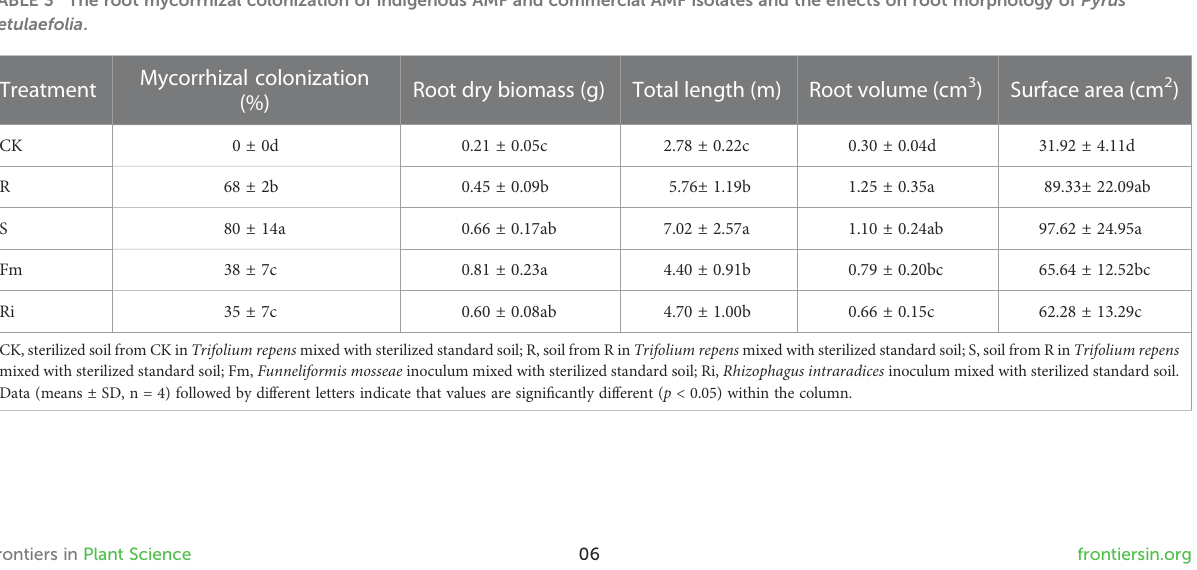
TABLE 3 The root mycorrhizal colonization of indigenous AMF and commercial AMF isolates and the effects on root morphology of Pyrus betulaefolia .